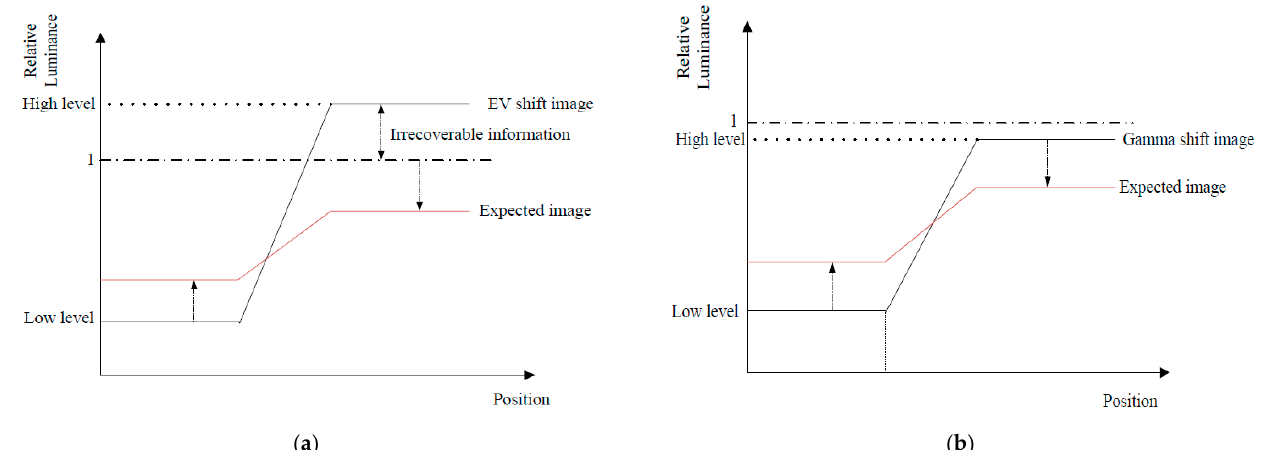
Figure 3. Difference in tone compression: ( a ) EV shift and ( b ) gamma shift.